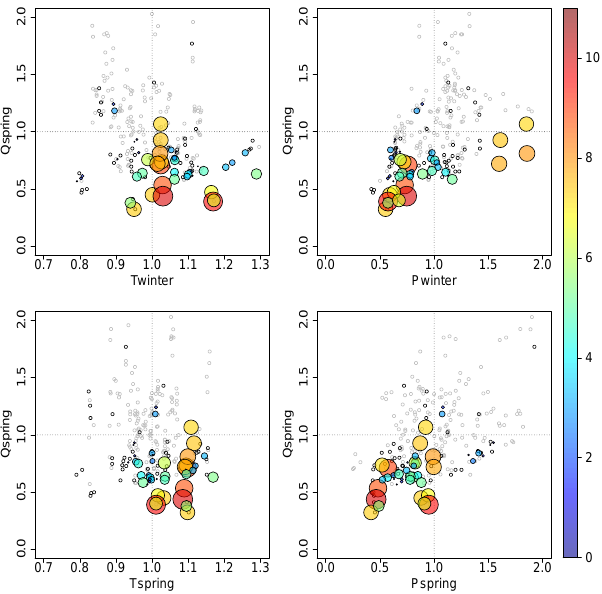
Figure A2. Snowmelt drought events in Norwegian catchments Figure A1. Snowmelt drought events in Austrian catchments based Figure 13. Snowmelt drought events in Norwegian catchments based on simulated discharge: Figure 12. Snowmelt drought events in Austrian catchments based on simulated discharge: stan- based on simulated discharge: standardised spring discharge on simulated discharge: standardised spring discharge ( Q spring ) standardised spring discharge ( Q spring ) [–] against standardised causing factors ( T winter , P winter , dardised spring discharge ( Q spring ) [–] against standardised causing factors ( T winter , P winter , ( Q spring ) (–) against standardised causing factors ( T winter , P winter , T spring , P spring ) [–]. Below 1 = below average, above 1 = above average. Grey circles: all years, (–) against standardised causing factors ( T winter , P winter , T spring , T spring , P spring ) [–]. Below 1 = below average, above 1 = above average. Grey circles: all years, T spring , P spring ) (–). Below 1 = below average; above 1 = above black circles: all drought years, coloured circles: snowmelt drought years (size and colour of dots P spring ) (–). Below 1 = below average; above 1 = above average. black circles: all drought years, coloured circles: snowmelt drought years (size and colour of dots average. Grey circles: all years; black circles: all drought years; is dependent on standardised drought deficit [–], scale on right side of figure). NOTE: selection of Grey circles: all years; black circles: all drought years; coloured is dependent on standardised drought deficit [–], scale on right side of figure). NOTE: selection of (snowmelt) drought years and size and colour of dots is based on observed discharge. coloured circles: snowmelt drought years (size and colour of dots (snowmelt) drought years and size and colour of dots is based on observed discharge. circles: snowmelt drought years (size and colour of dots are depen- are dependent on standardised drought deficit (–); scale on the right dent on standardised drought deficit (–); scale on the right side of side of the figure). Note: selection of (snowmelt) drought years and the figure). Note: selection of (snowmelt) drought years and size 55 size and colour of dots is based on observed and colour of dots is based on observed discharge.